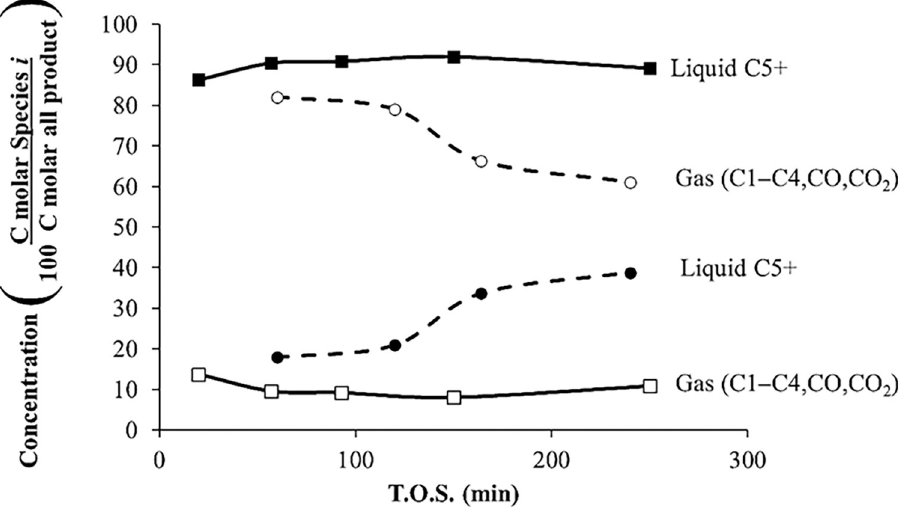
Fig 3. Product distribution of gases and liquids for the acetone reaction over HZSM-5(80) (dashed line) and HZSM-5(280) (solid line), T = 415˚C, WHSV = 1.3 h –1 , and P = 101 kPa (abs).